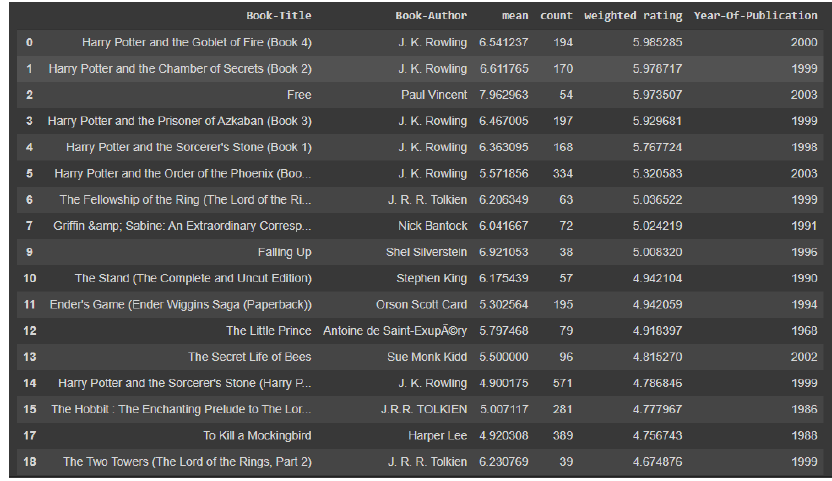
Fig. 2. List of top 20 rating book